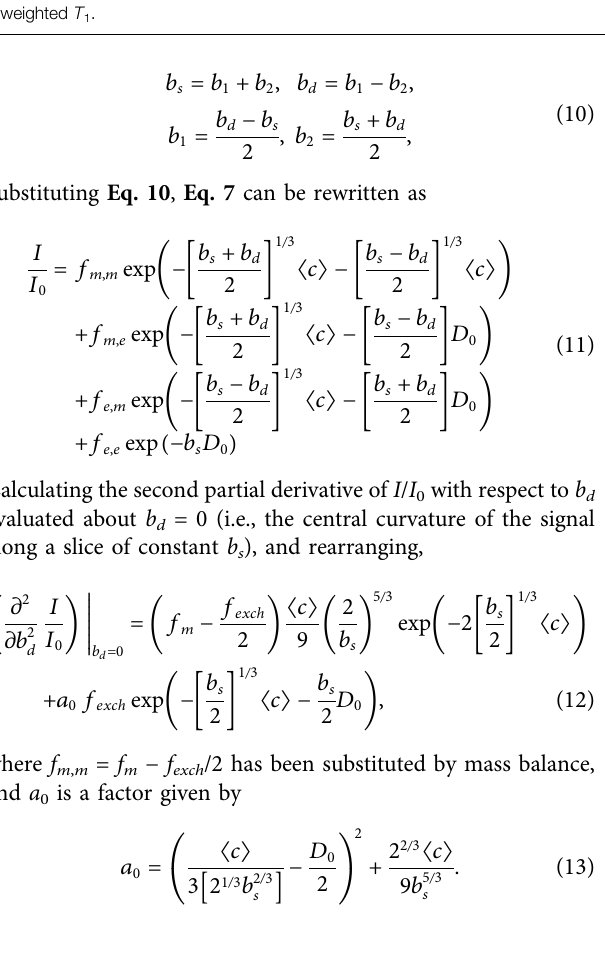
FIGURE3| DescriptionoftheproposedREEDS-DENMRacquisitionscheme.Parametersareobtainedintwosteps. (A) Inthe fi rststep, Δ I valuesmeasuredattwo ormore b s near t m =0are fi tto Eq.18 ,yielding f m and 〈 c 〉 .The b s valuesshouldbechosentosatisfy ℓ d ≳ ℓ g . (B) Inthesecondstep, Δ I valuesmeasuredatoneormore t m > 0 ata fi xed b fi rststepforthecorrectionterm, Δ I ( t s areusedtocalculate f exch ( t m )from Eq.20 ,utilizingthe m =0)(see Section3.2.3 ).Finally,the t m dependenceof f exch is fi t to Eq. 9 , yielding k . The steady-state f − f exch at long t m should agree with 2 f m (1 m ). Marginal points along b 1 or b 2 = 0 may be used to measure the diffusion- weighted T 1